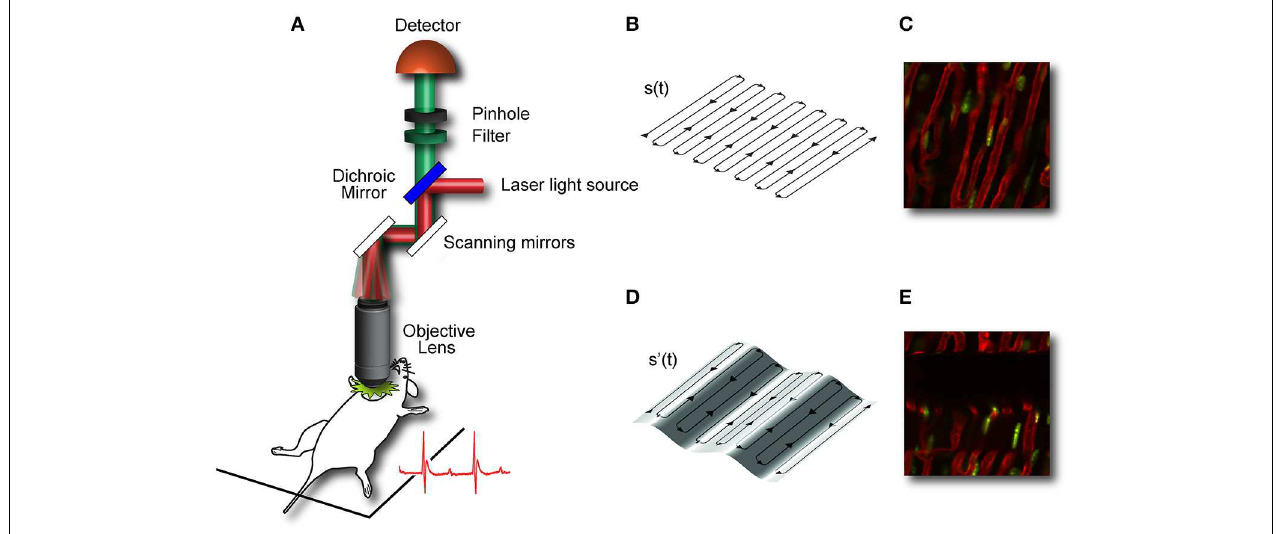
FIGURE 4 | Image acquisition in laser scanning microscopy (LSM) is based on sequential point-by-point excitation. Fluorescence emission is detected in epi-collection along a scanned (A) or de-scanned detection path, depending if confocal or multiphoton microscopy is chosen. The collection of the signal in correspondence of each point along the scanning path gives rise to an image. When the imaged subject is stationary, the excitation scanning point draws a pre-defined trajectory across a horizontal imaging plane